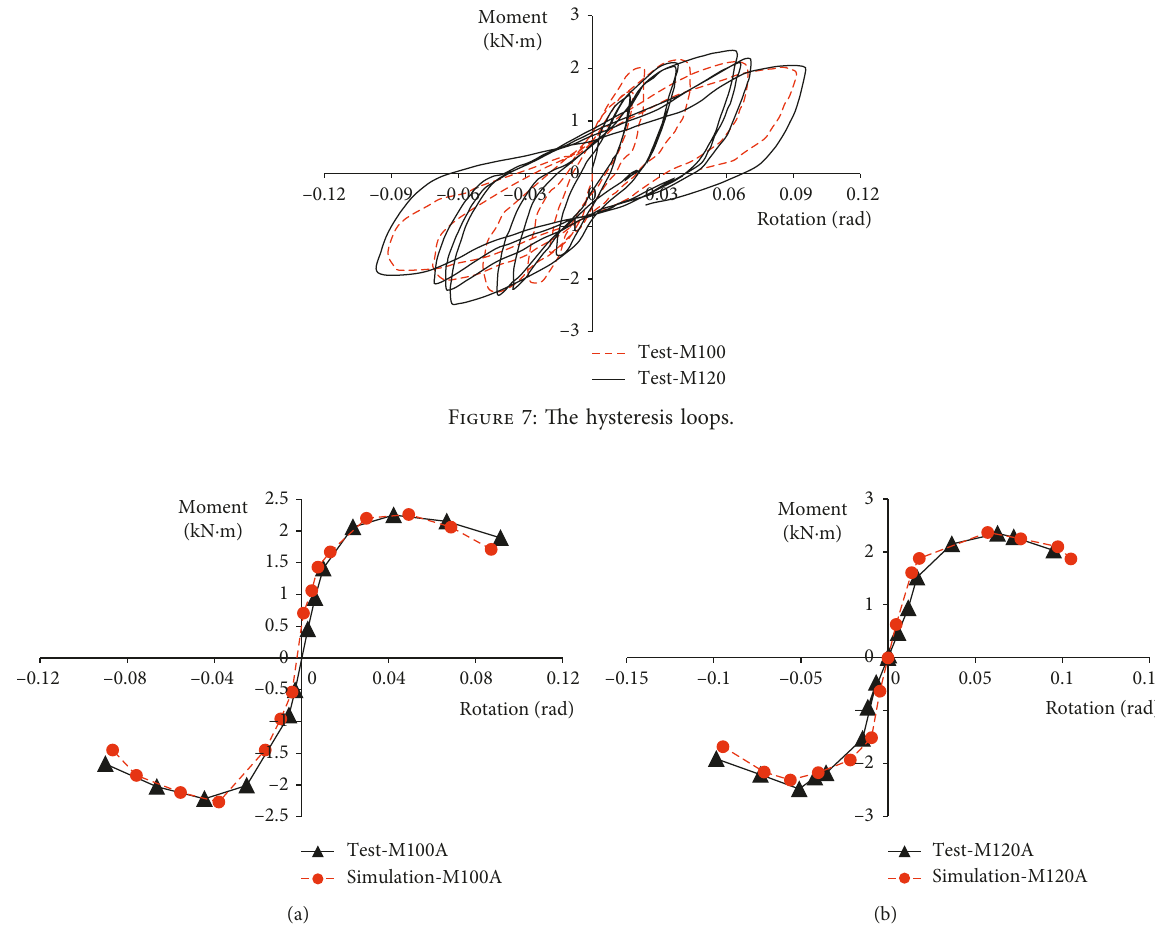
Figure 8: Comparison of experimental and simulation backbone curves. (a) M100 and (b) M120.